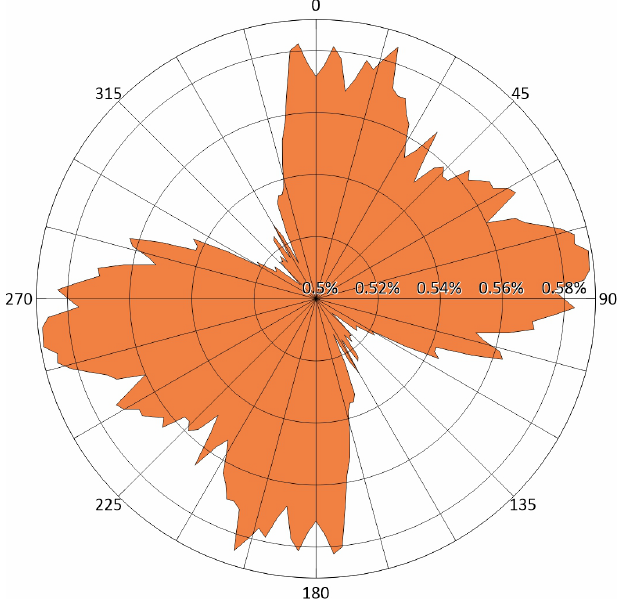
Figure 10. Rose diagram of the bedrock of the research area.